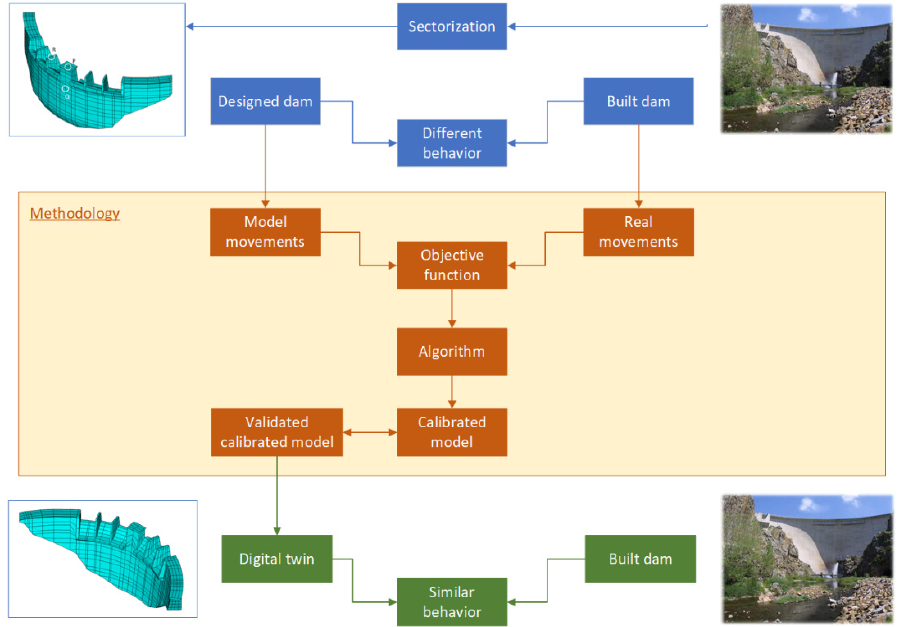
Figure 1. Process to develop a sectorized digital twin.